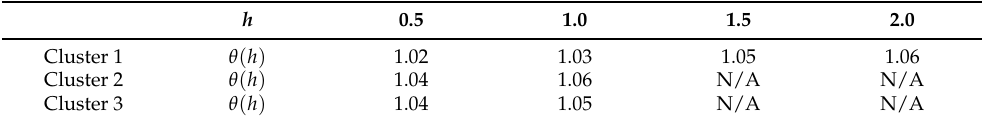
Table 10. Estimation of the extremal index for the temperature